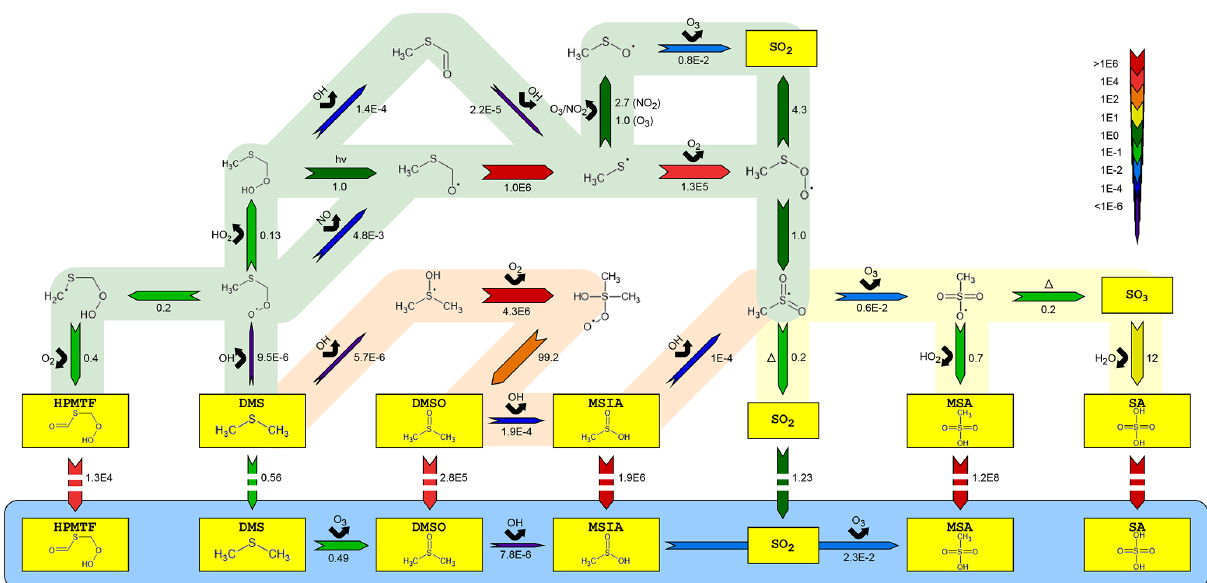
Figure 2. Simplified mechanism of the OH-initiated oxidation of DMS. Reaction rates are reported per second s − 1 for gas-phase and aqueous-phase chemistry and in units of per atmosphere, mol/(kg atm), for phase transfers (marked with broken arrows). All have been estimated at 293K, 5%RH and relevant OH, O 3 , HO 2 , NO and NO 2 concentrations in the AURA smog chamber. The blue area denotes the aqueous-phase oxidation of important water-soluble intermediates and products (marked in yellow). Red and green shaded areas represent the OH addition and H abstraction pathways, respectively, while the yellow area illustrates the remaining mechanism after the two previous pathways intercept. The number beneath each arrow denotes the rate of the said reaction and the chemical species above its